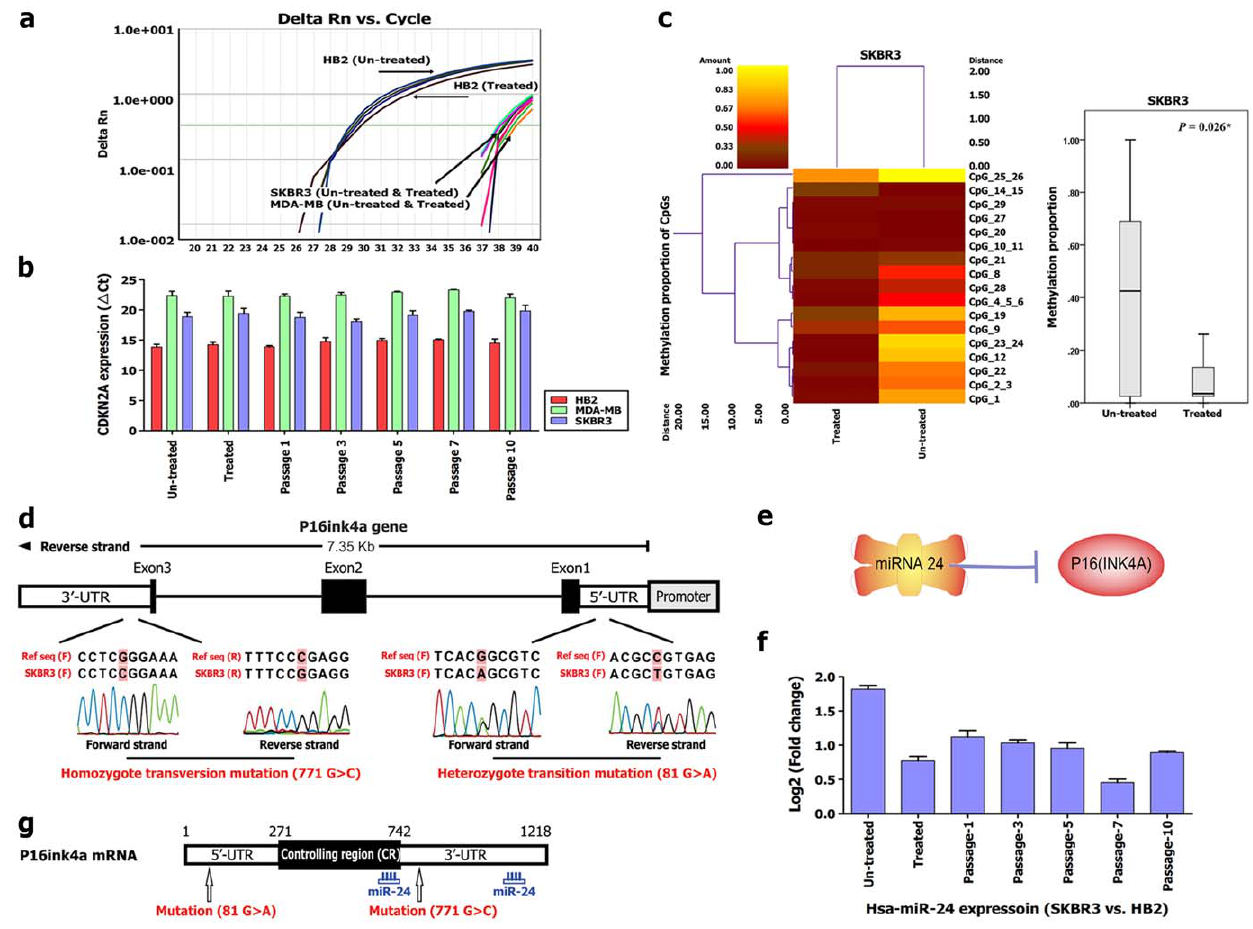
Figure 7. Epigenetic regulation of P16-INK4A tumor suppressor gene. a) Expression profile of P16-INK4A in treated and untreated cell lines; in two cancerous cell lines (MDA-MB231 and SKBR3) no expression was detected. b) Expression profile of P16-INK4A within all analyzed passages according to the normalized Ct values ( D Ct). c) Methylation proportion of informative CpG sites of P16-INK4A in SKBR3 cell line. d) Full gene sequencing of P16-INK4A revealed a heterozygote transition mutation in 5 9 UTR and a homozygote transversion mutation in 3 9 UTR of the gene. e) Pathway analysis predicts the role of has-miR-24 (MIRN24) as a down-regulator of the P16-INK4A . f) Expression profile of has-miR-24 in the non- aggressive breast cancerous cell line (SKBR3) versus control breast cell line (HB2). g) Comparison of miR-24 recognition site with the location of found mutations in the mature P16-INK4A mRNA.